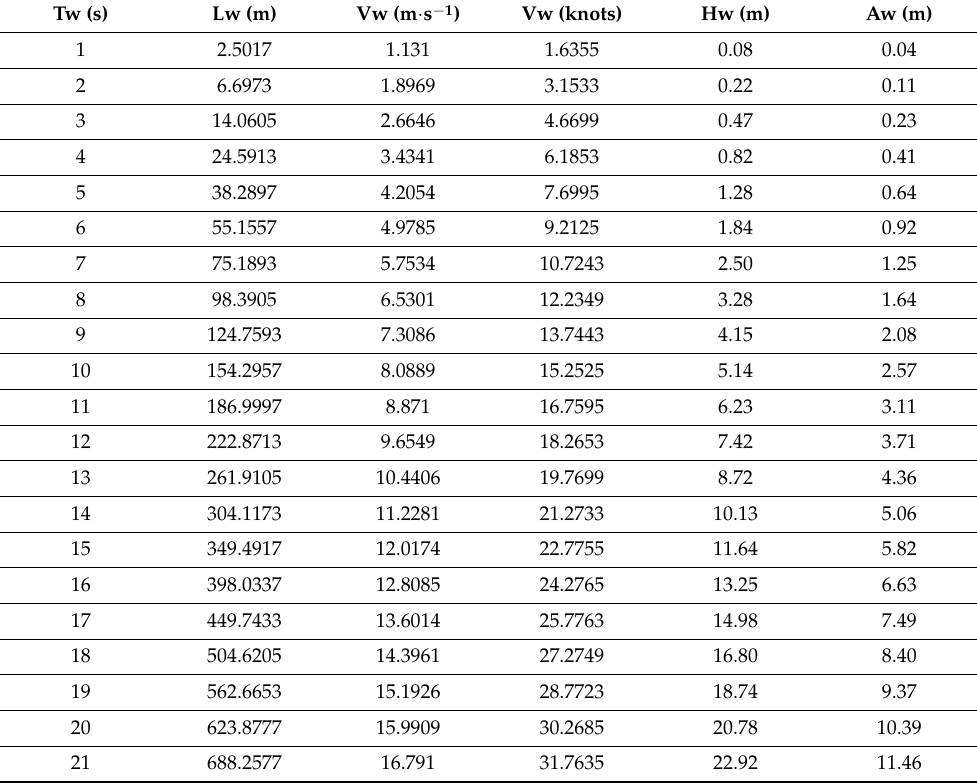
Table 1. Data of studied waves.